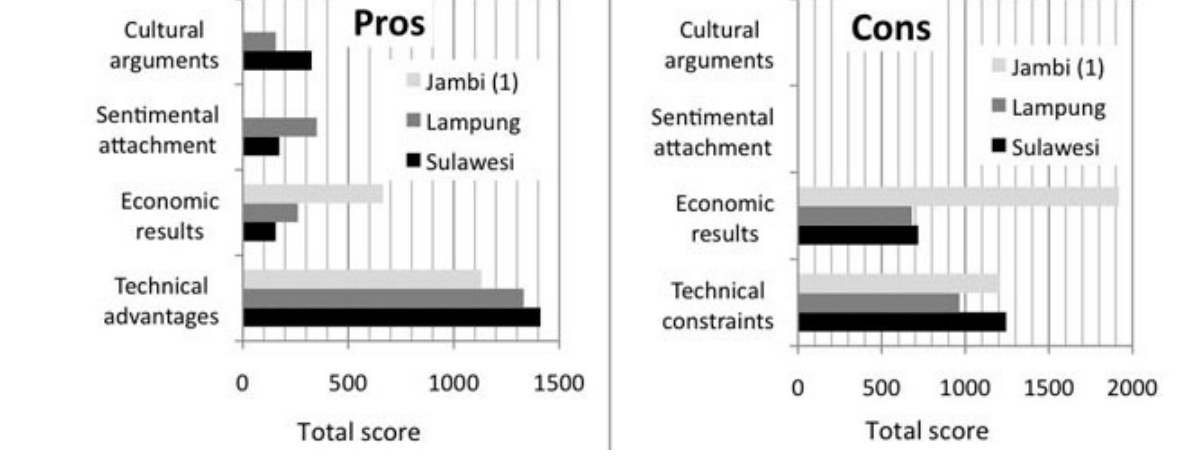
Fig. 2 . Pros and cons of agroforests compared with monoculture plantations (results of the perception survey) (adapted from Therville 2008). “Cultural arguments” includes inheritance from grandparents, staple food production, and daily domestic consumption products. “Sentimental attachment” includes attractive scenery and site of usual daily work. “Economic results” includes low costs of plantation and production, high return to land, easy commercialization, stable and high price of the commodity, and long production period. “Technical advantages” or “constraints” includes resistance to pests, low labor requirements, wide variety of products, no seasonality, tree cover that protects workers against sun and rain, protection of soil fertility and erosion prevention, and trees that live longer and can be replaced one by